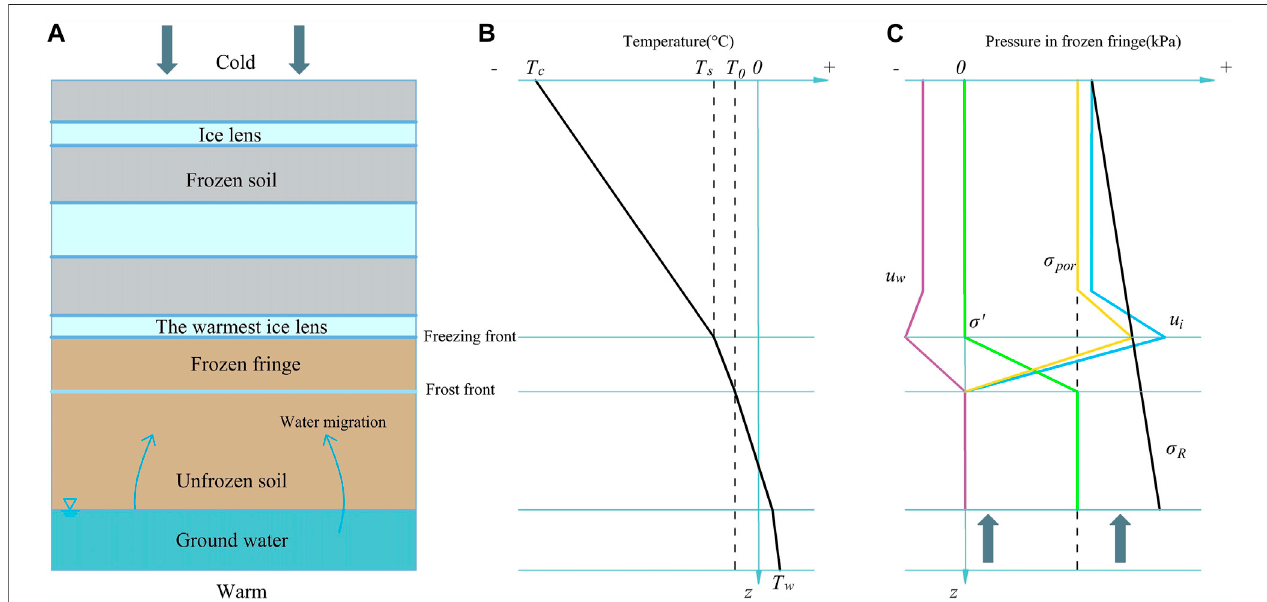
FIGURE 5 | The temperature and pressure of the frozen fringe (based on a static model of the frozen fringe by Ma et al. (2015): (A) the location of the ice lens and frozenfringe; (B) temperatureinthefrozenfringe. T C and T W aretheupperandlowerboundarytemperatures,respectively; T S isthesegregatedtemperature;and T 0 is the soil freezing point; (C) pressure in the frozen